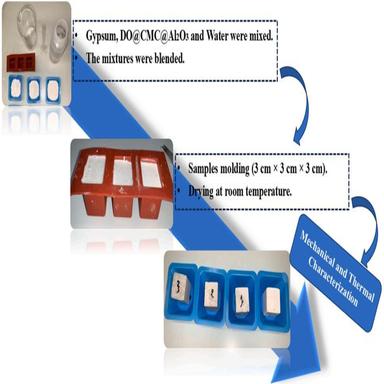
Preparation steps for Gypsum/PCM blocks with different DO@CMC@Al2O3 mass ratios.